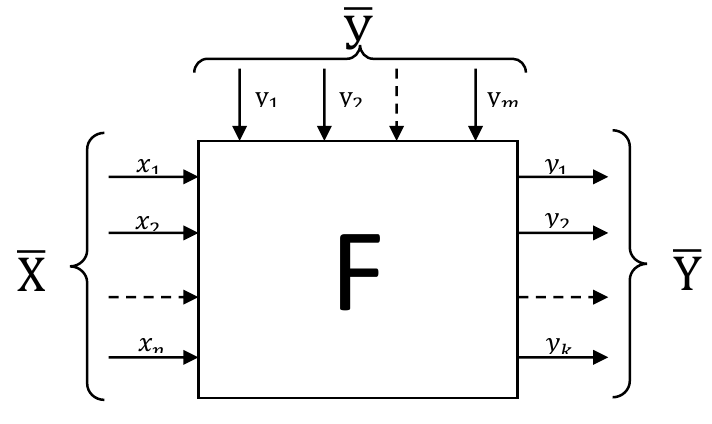
Figure 1. Information model of the OVS-25S grain pre-cleaner technological